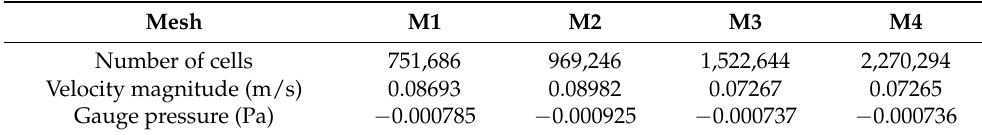
Table 3. Mesh sensitivity analysis at the center of the farmers’